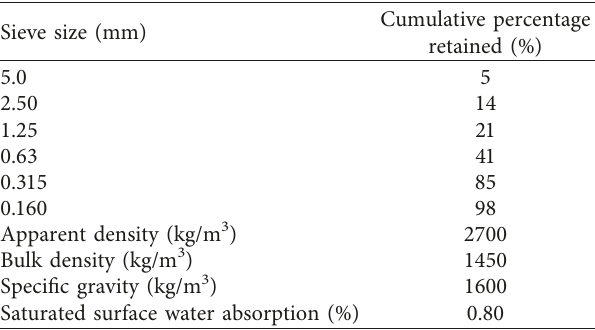
Table 2: Particle size distributions and physical properties of sand.